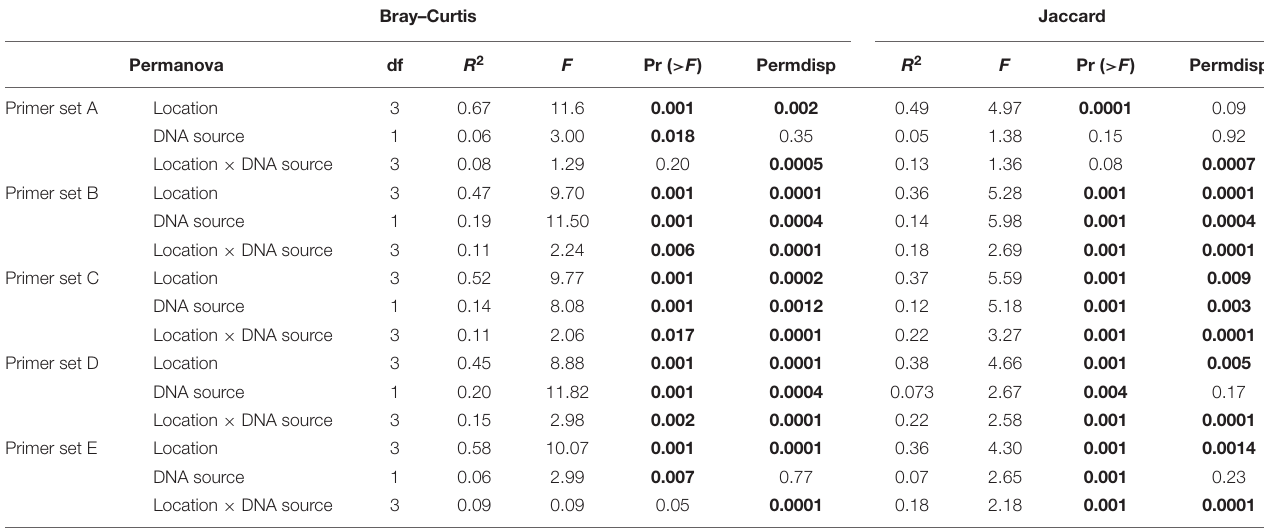
TABLE 2 | PERMANOVA and Permdisp results based on 9,999 permutations for each of the five primer sets using Bray–Curtis distance or the Jaccard index. Bray–Curtis